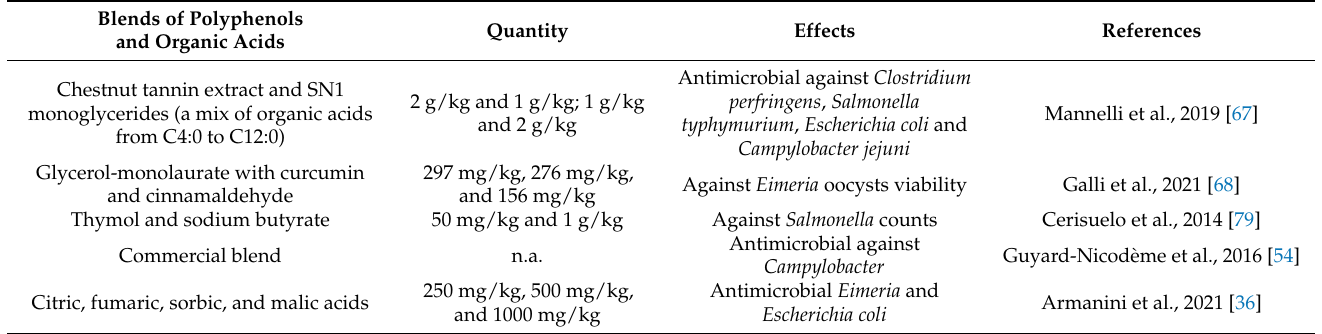
Table 3. Examples of blends of polyphenols and organic acids studied as antimicrobials. Blends of Polyphenols Quantity and Organic Acids